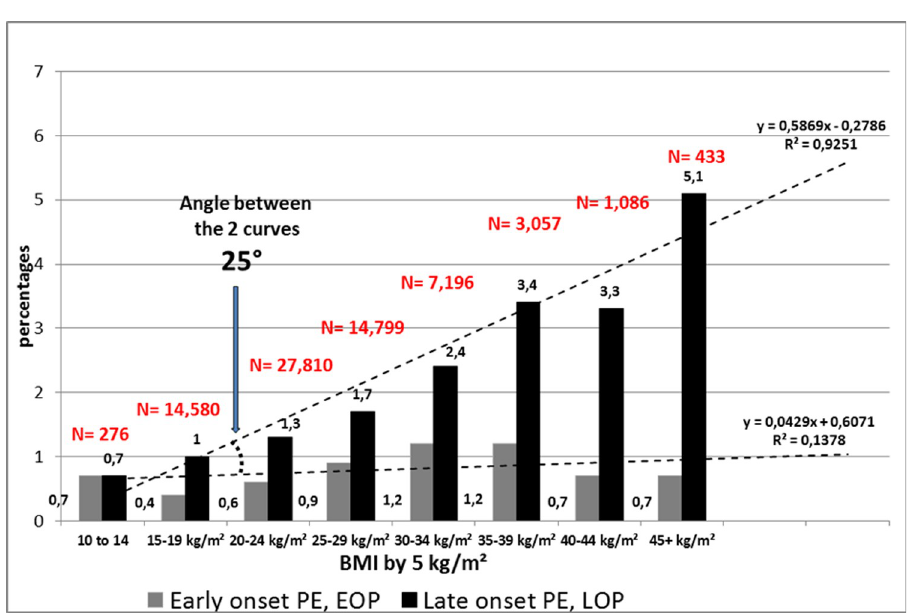
Fig 1. Prevalence (%) of EOP and LOP per categories of BMI, South Reunion 2001–2018. 1,736 preeclampsia. 1,587 preeclampsia with BMI, 491 EOP (30.9%) and 1,096 LOP.